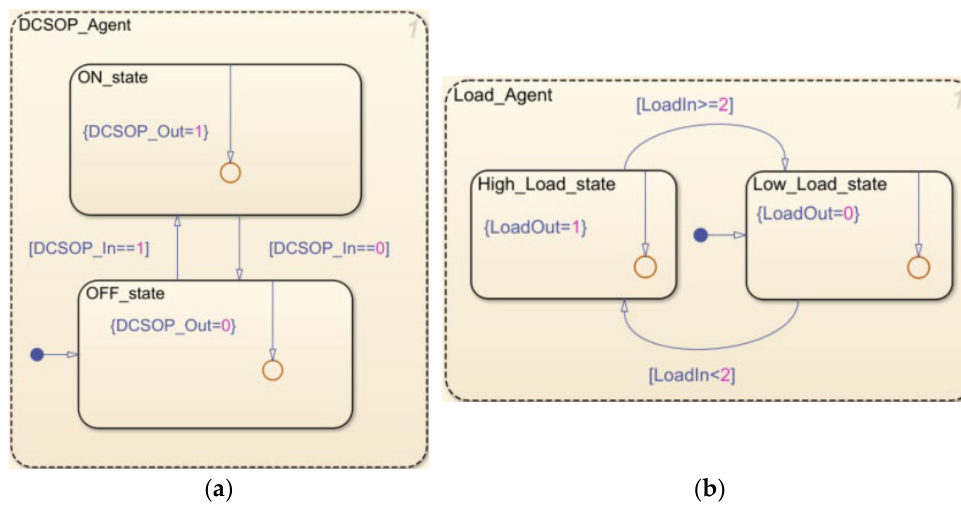
Figure 9. DCSOP agent ( a ) and load agent ( b ) implementation in